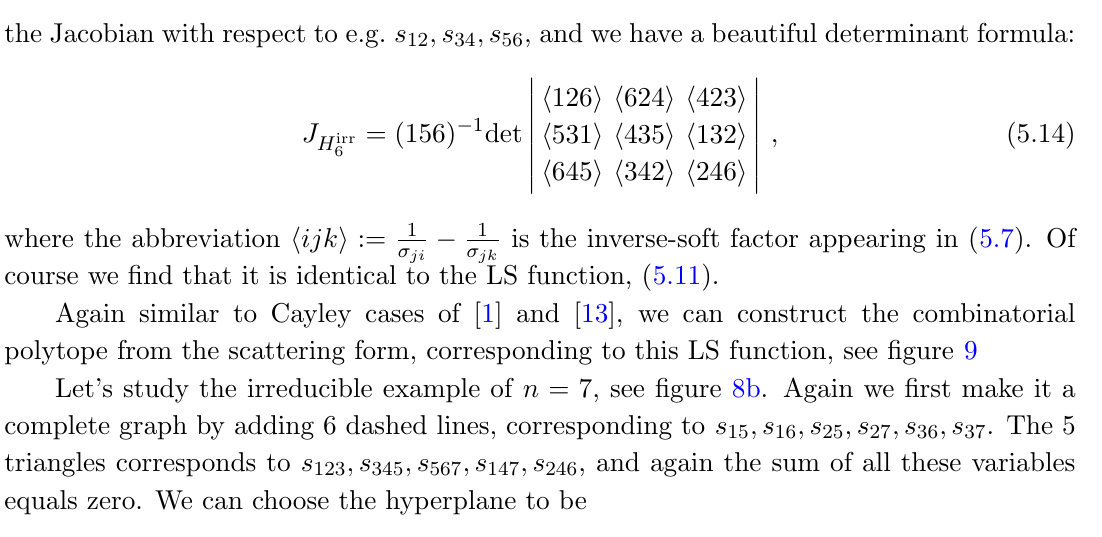
Figure 8. Diagrammatic representation for LS